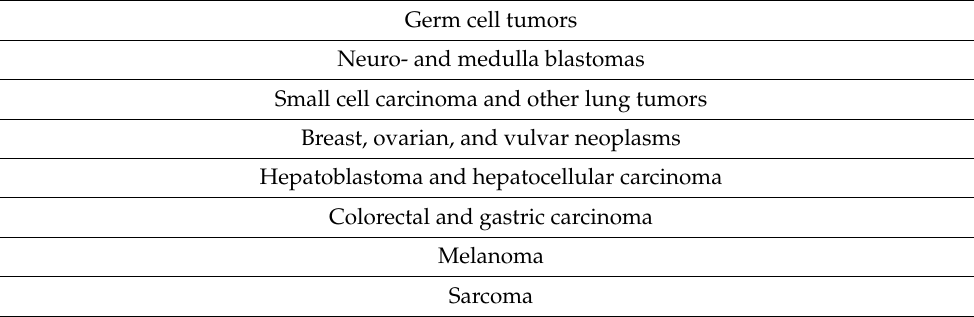
Table 2. Solid tumors associated with tumor lysis syndrome